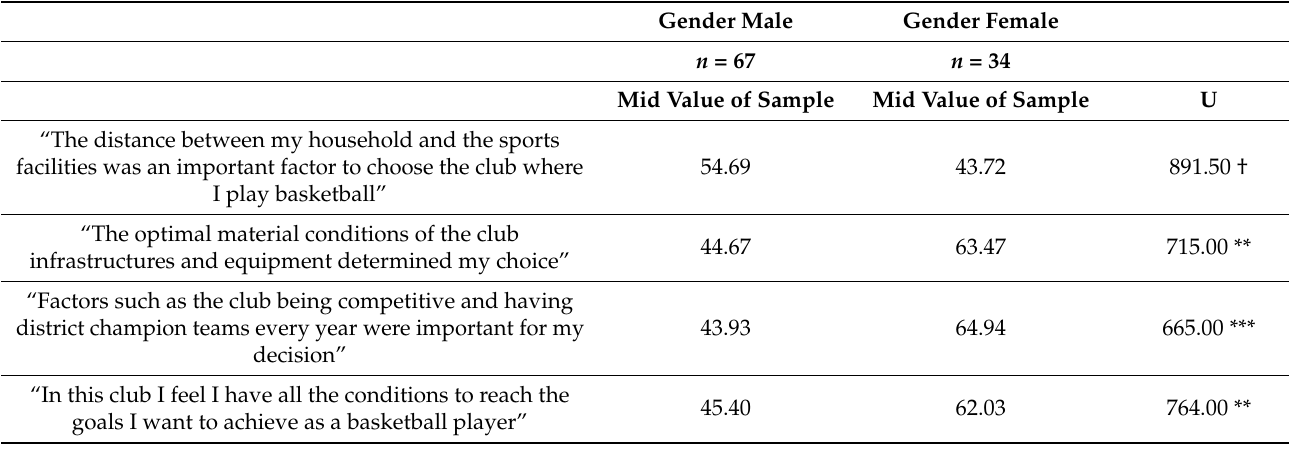
Table 1. Differences and associations at the gender level: